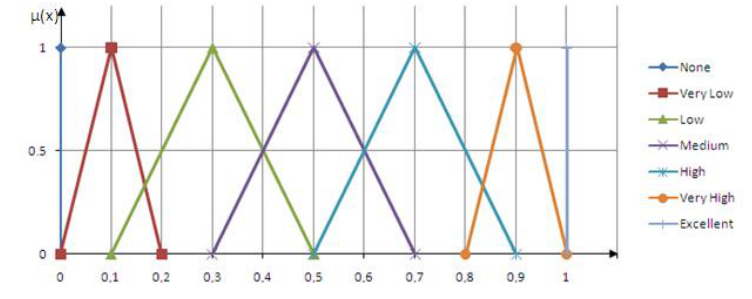
Figure 5. Linguistic scale for